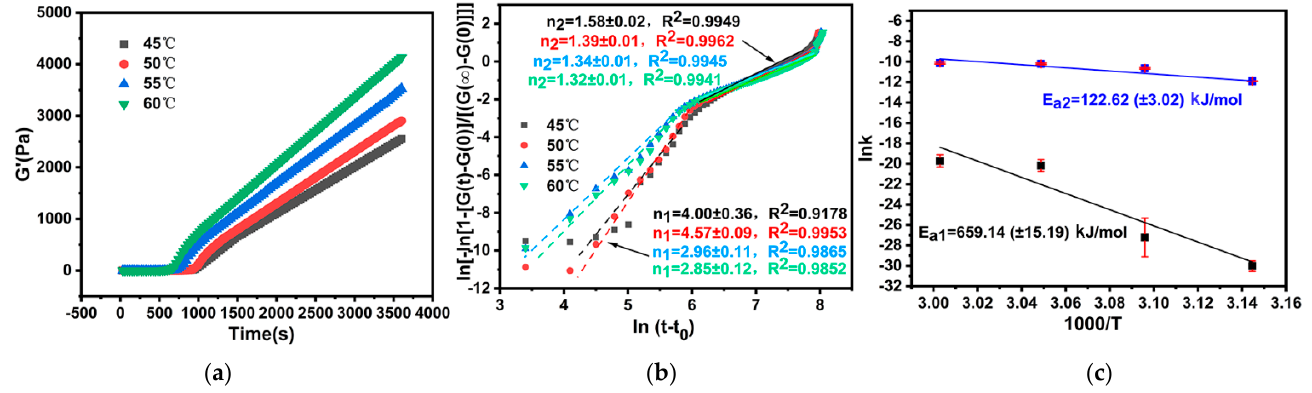
Figure 2. ( a ) Composite viscoelastic modulus. ( b ) Avrami dynamics model. ( c ) Activation energy during gelation at 4560 °C.